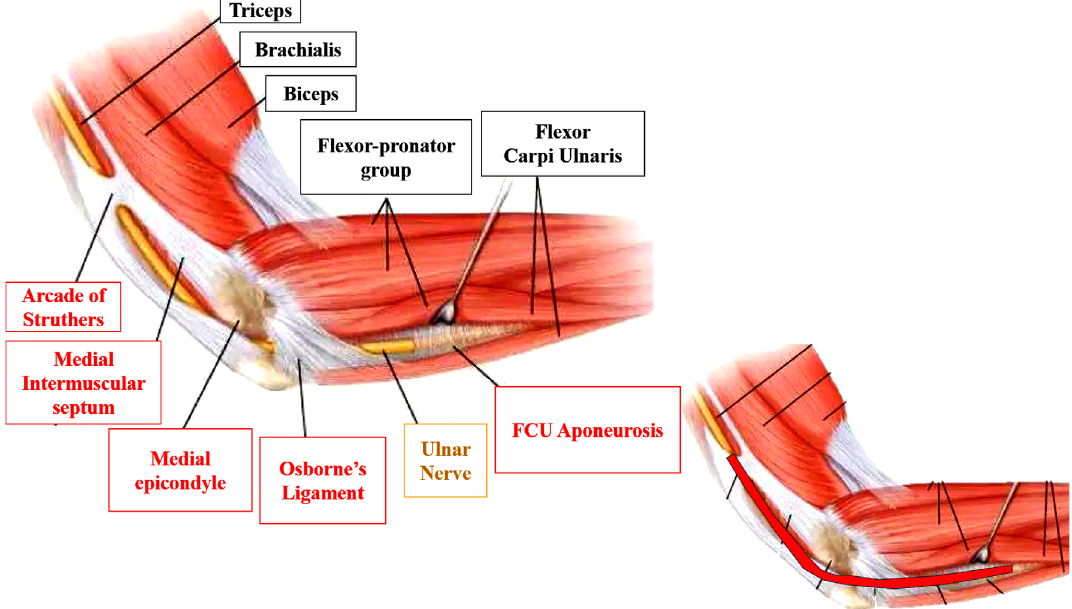
Figure 1. Schematic view of the medial elbow with possible sites of ulnar nerve compression (in red rectangles). At the bottom left, the release rate represents the percentage of the colored area ’ s length that was found to be sectioned upon